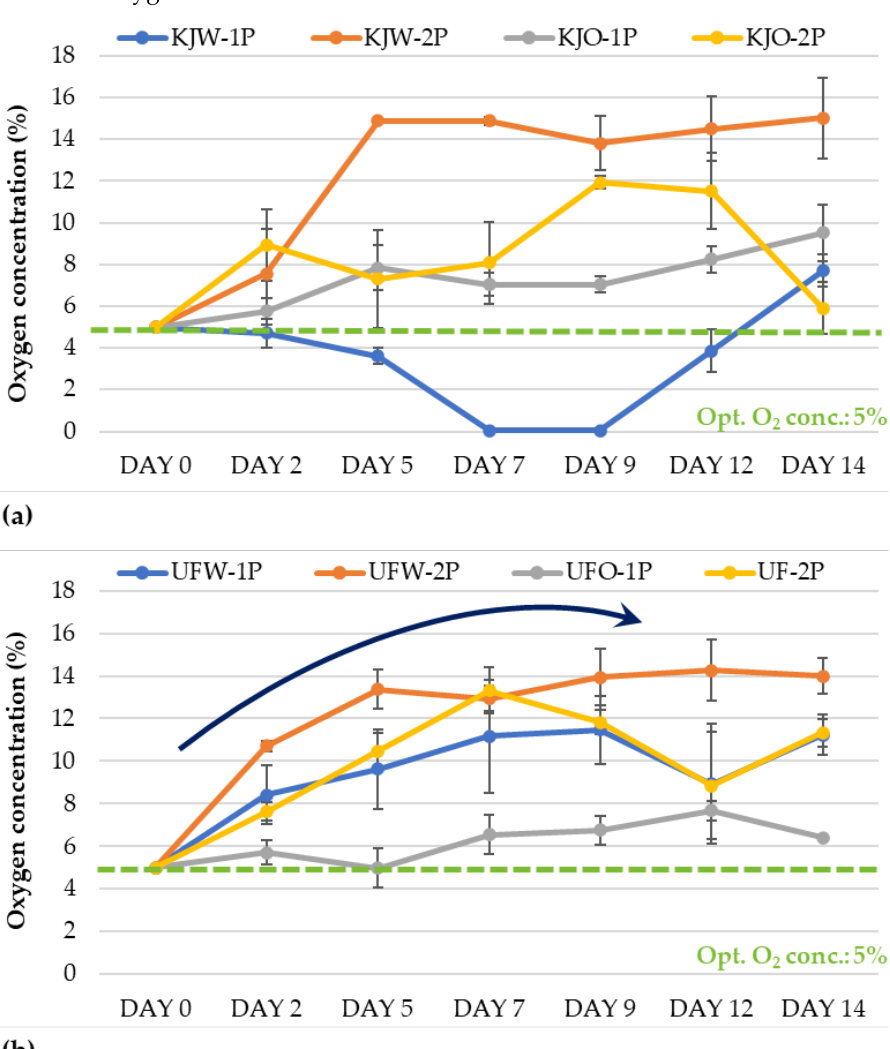
Figure 2. Change in headspace oxygen concentration in modified atmosphere packages of ( a ) ‘K á ntorj á nosi’and ( b ) ‘ Ú jfeh é rt ó i fürtös’ sour cherries with different washing pretreatments. In the ‘ Ú jfeh é rt ó i fürtös’ samples, a saturation trend was observed in oxygen